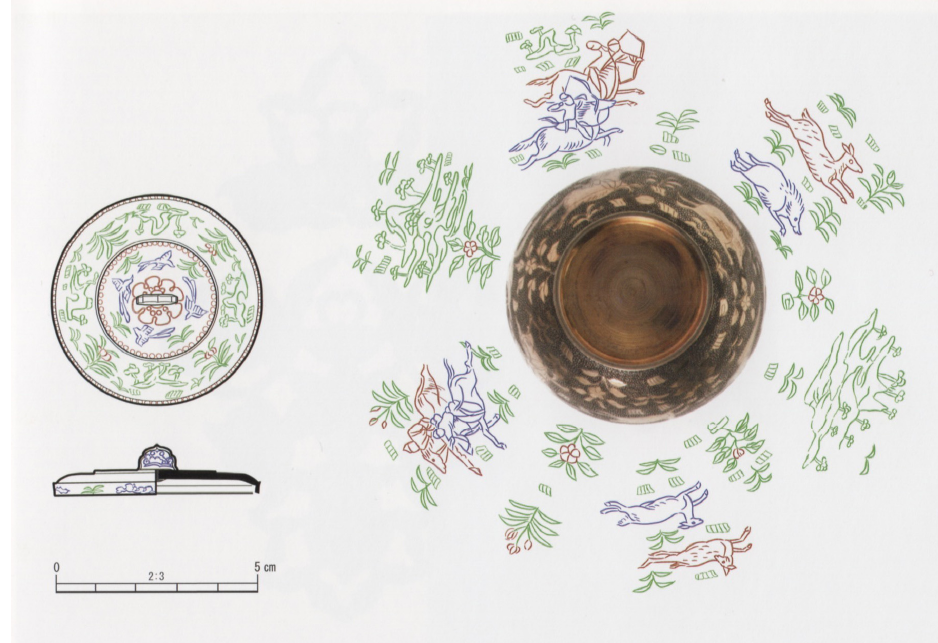
Figure 11. Diagram of motifs on silver lidded jar with hunting scene. Reproduced from Gang ō ji Bunkazai Kenky ū jo (2015), p. 183. Ascension is a reoccurring theme in Buddhist devotion (and more broadly in the East Asian imagination of the celestial). In the context of the T ō daiji objects, however, one could